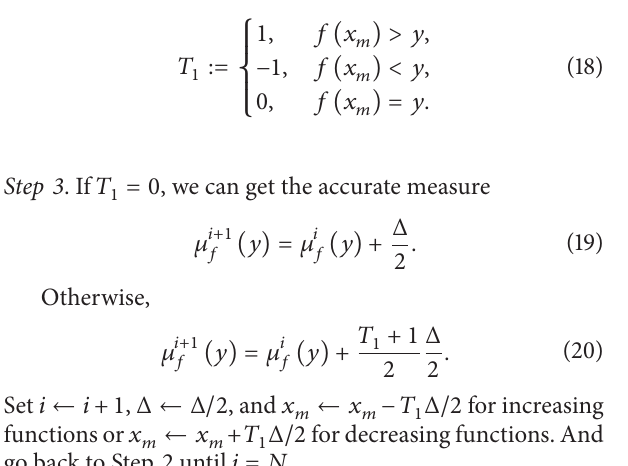
Algorithm 3 (split-half algorithm). Consider the following